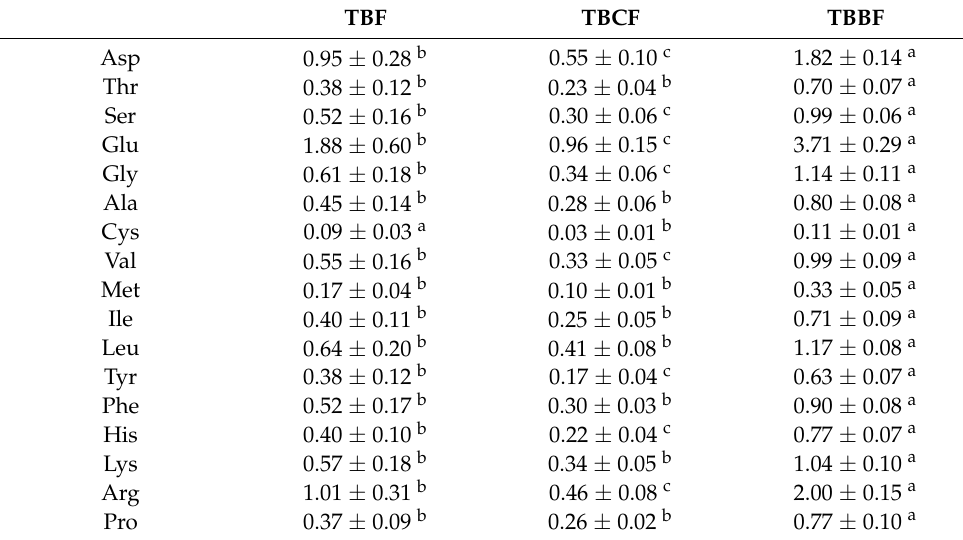
Table 3. Amino acid composition (%) of TBF, TBCF, and